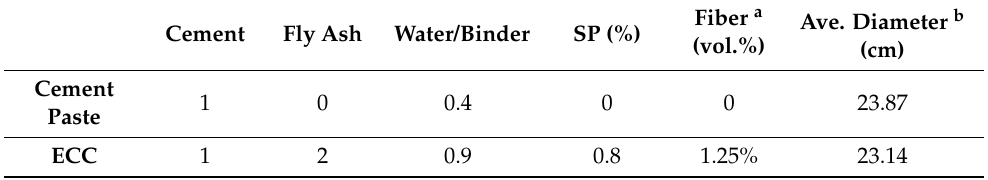
Table 1. Mix proportion of the specimens (mass ratio).